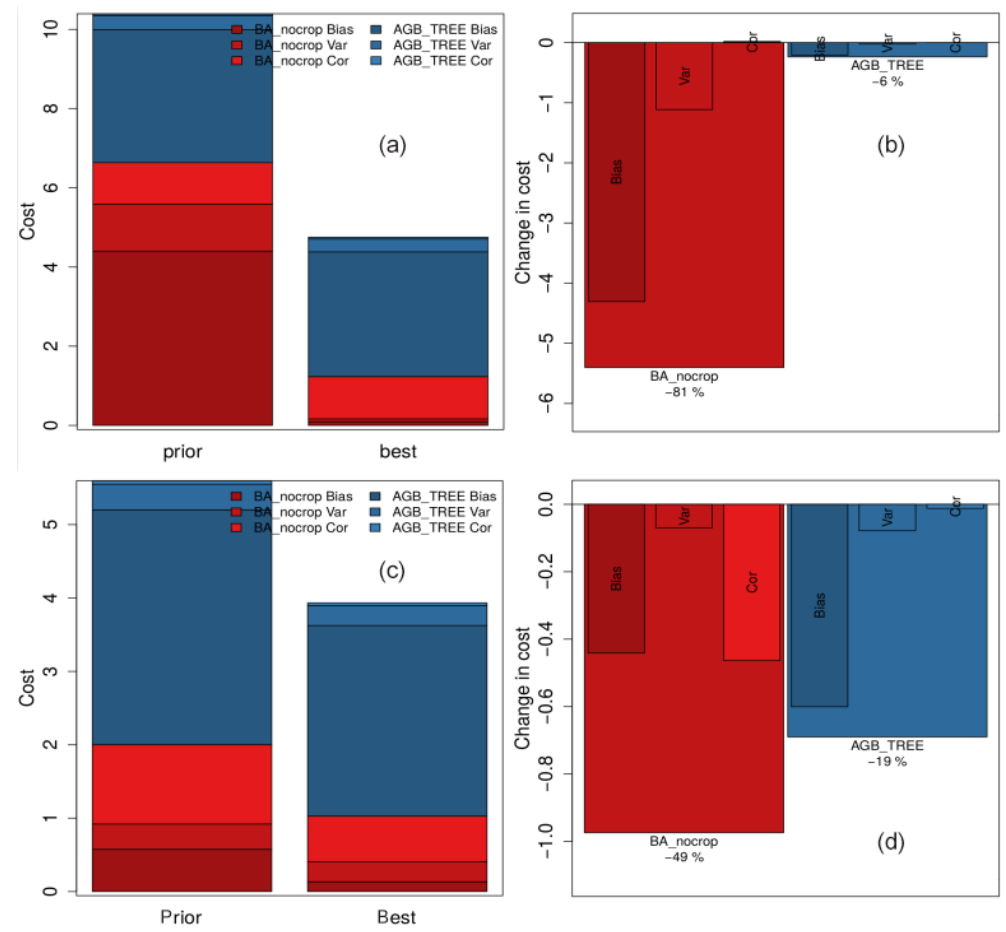
Figure A4. Cost reduction of the burned area and the biomass during the optimization process by showing the various components of the cost that are related to model–data bias, variance ratio, and correlation. The cost for burned area for NI optim decreased by ca. 81%, whereas the cost of the biomass only decreases by ca. 6% (a, b) . For VPD optim the cost decreased by ca. 48% for burned area and ca. 19% for the biomass (c, d) . Hence the impact of the optimization process on burned area is much larger due to the focus on fire